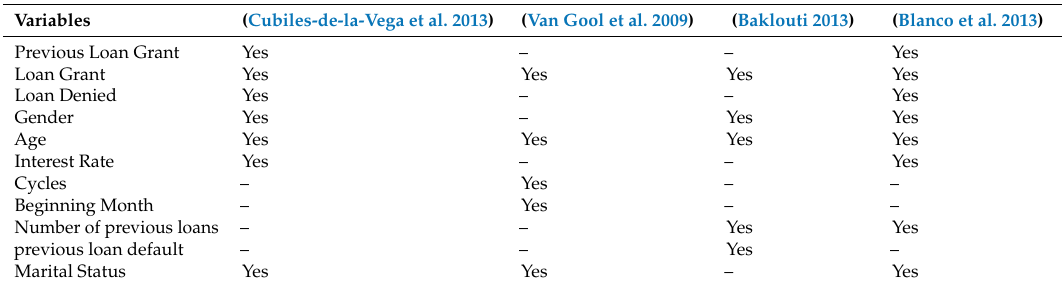
Table 2. Variables highlighted by the meta analysis.